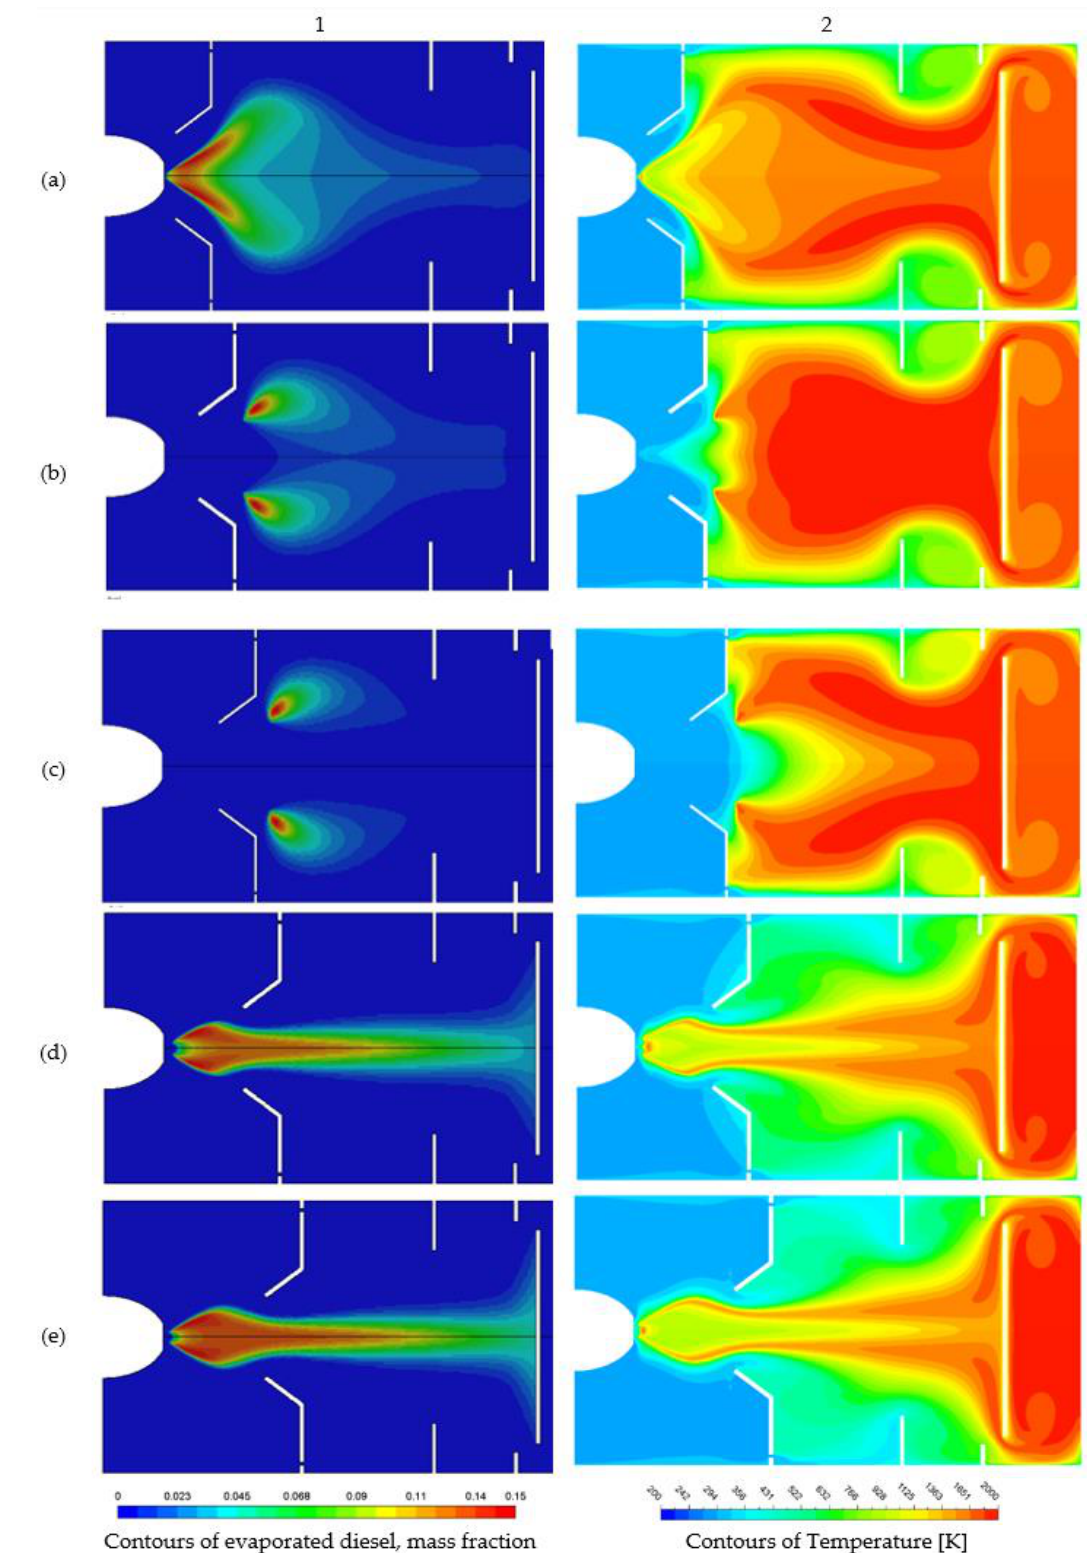
Figure 9. Contours of evaporated fuel ( column 1 ) and temperature ( column 2 ) for cases ( a – e ) of relocating the ring cone. In case ( c ), the ring cone is at the same distance from the nozzle as in the baseline case (C) in Section 3.1.